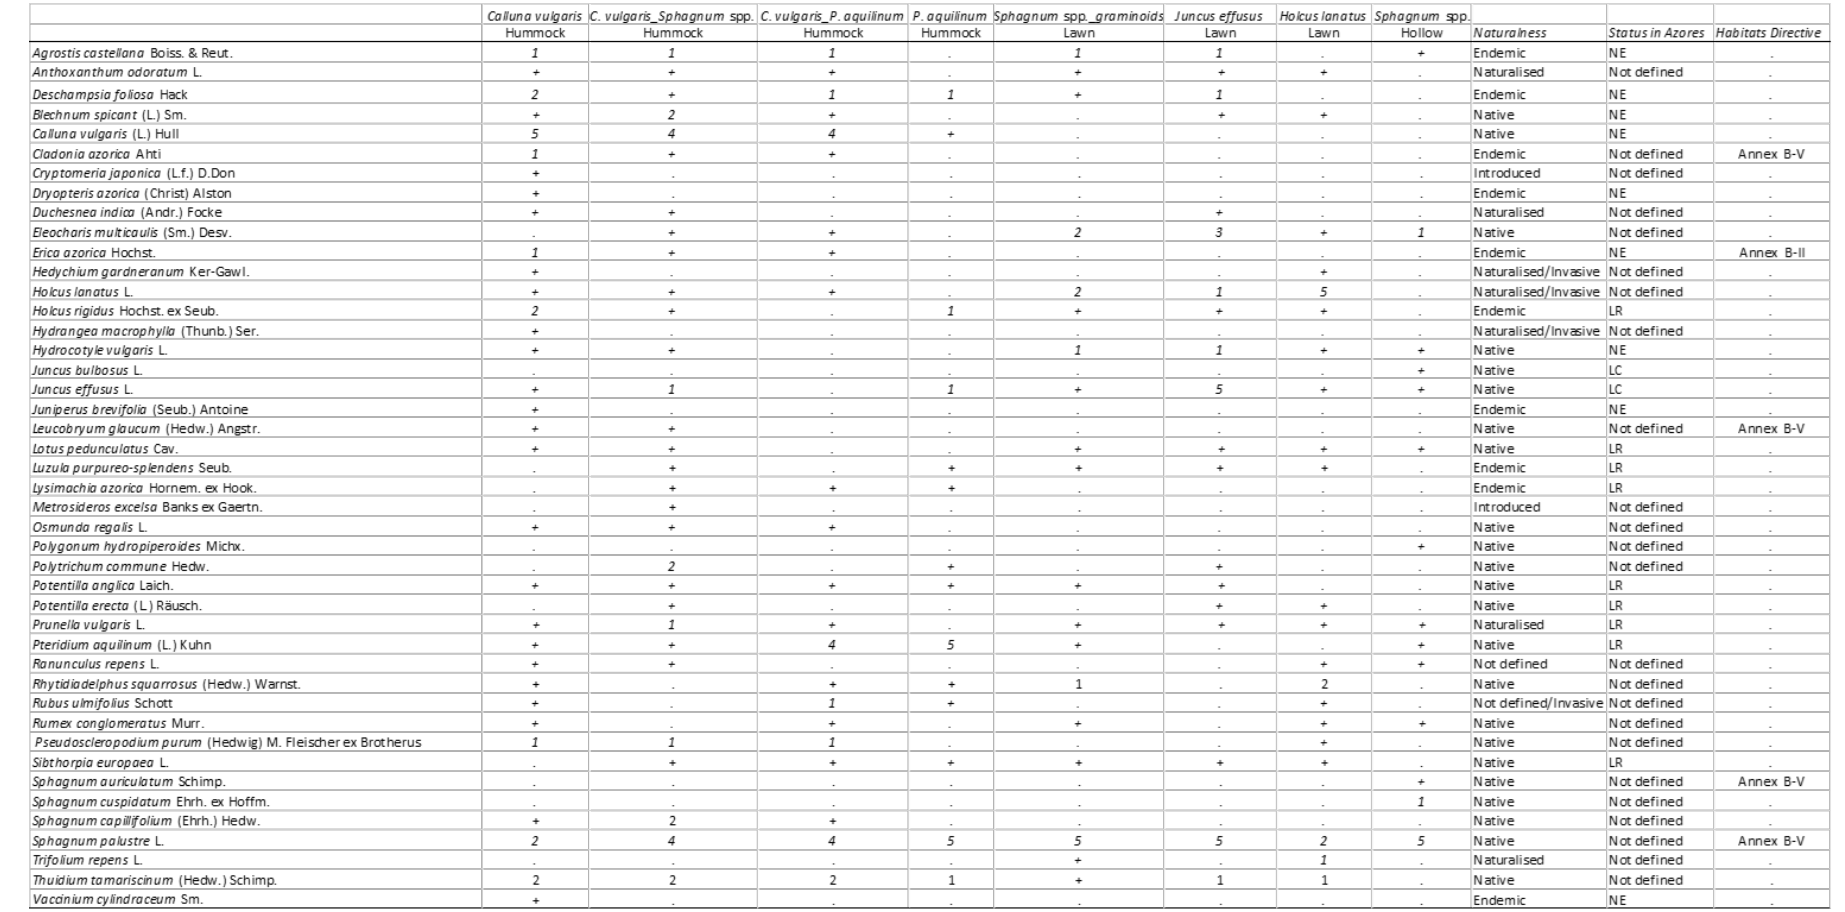
Table 2. Plant species in each community of the Criação do Filipe peatland complex. Species cover according to Braun-Blanquet classes. Designation of vegetation types is based on the dominant species. For each species, status and naturalness for the Azores is defined according to Dias (2016). Species listed in annexes II and V of the EU Habitats Directive are also